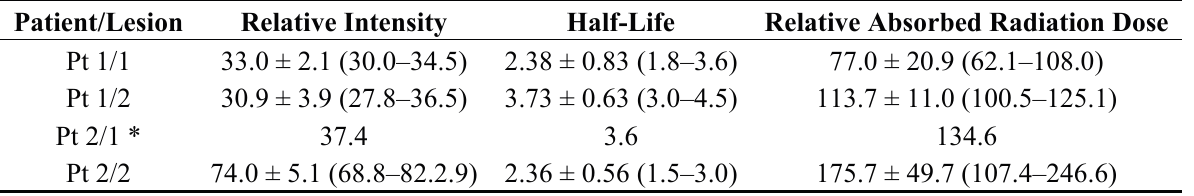
Table 1. Summary of serial gamma imaging measurements (I-VI 223 RaCl 2 cycles, measurements on days 0, 7 and